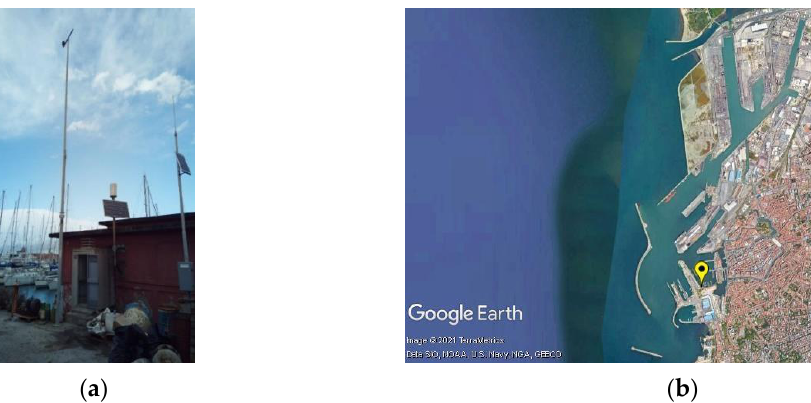
Figure 6. The ISPRA’s monitoring station in the port of Livorno: ( a ) the station (picture from https://www.mareografico.it/ (accessed on 25 October 2021)); ( b ) its position (10°17 ’ 57.62 ’’ E, 43°32 ’ 46.63 ’’ N, image from Google Earth).